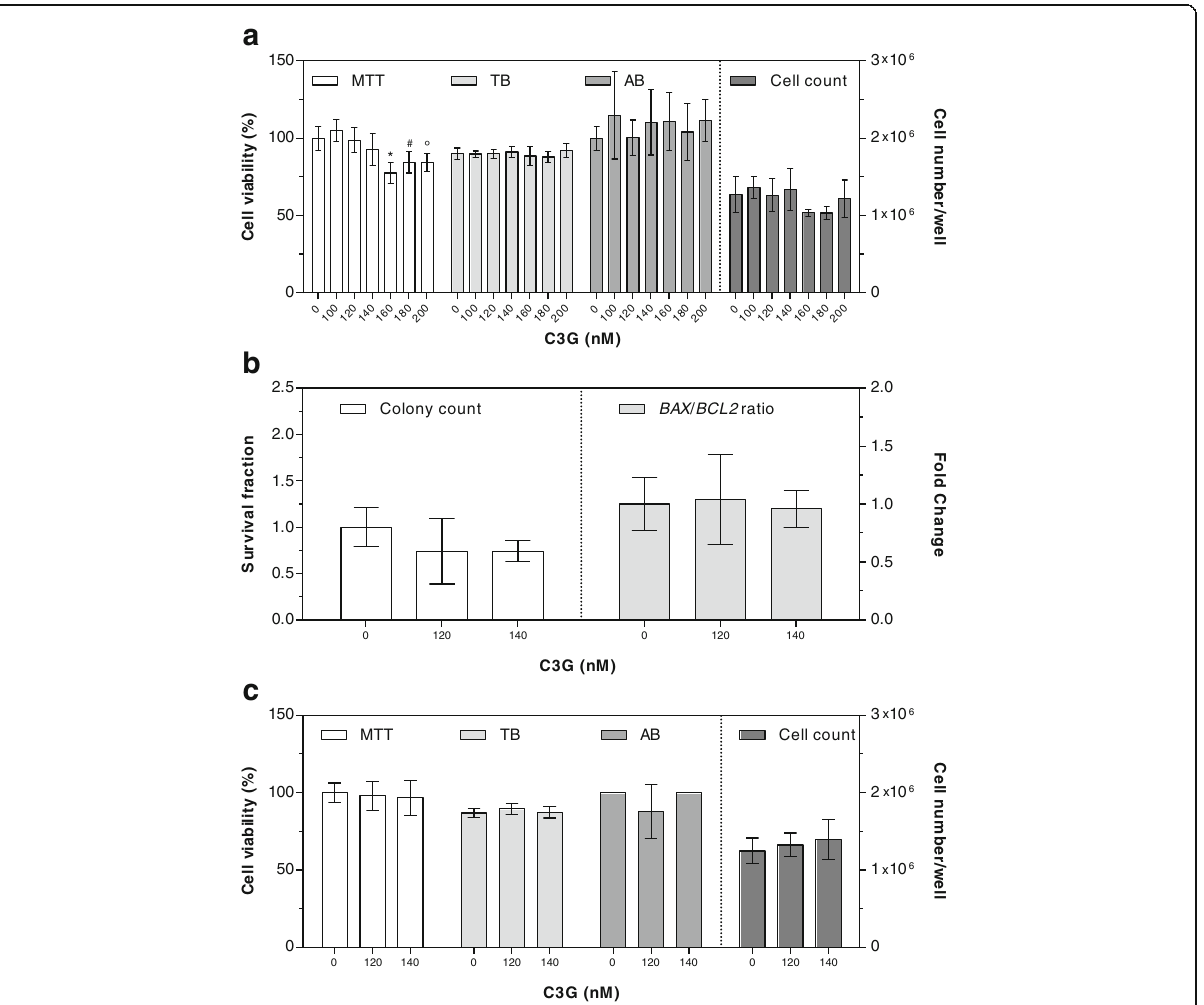
Fig. 3 Cytotoxic effects of C3G after 24 ( a , b ) and 48 ( c ) hours of supplementation. Cell viability by MTT and AB is expressed as percentage of control cells (assigned as 100%). TB is expressed as percentage of total cells. Cell count is expressed as number of cells per well. Colony count by clonogenic assay is expressed as survival fraction. BAX/BCL2 gene expression ratio is expressed as the mean fold change of relative expression compared to control cells, normalized to one. Data are means ± SD of six samples obtained from two independent experiments. Statistical analysis was by the one-way ANOVA (panel a : MTT p < 0.001, TB, AB, and cell count n.s.; panel b : colony count n.s., BAX/BCL2 ratio n.s.; panel c : MTT, TB, AB, and cell count n.s.) using Dunnett ’ s as post-test to compare supplemented cells to control ones (# p < 0.05; ° p < 0.01; * p <